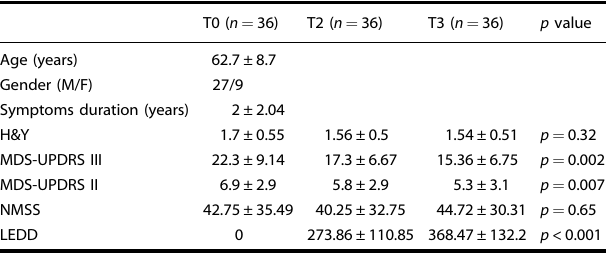
Table 1. Average and standard deviation of the clinical scores for patients at T0, T2, and T3.